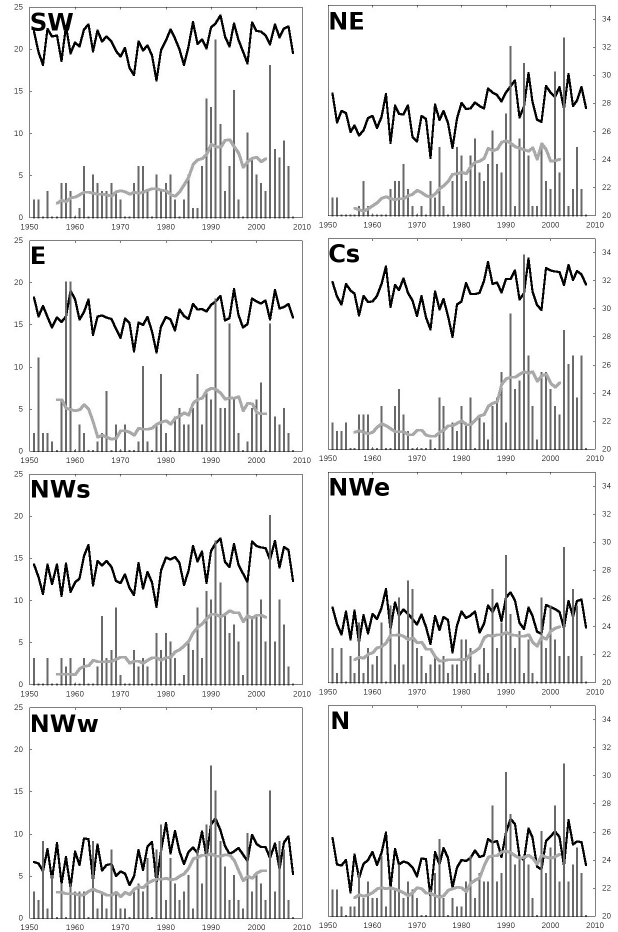
Figure 2. Temporal evolution of the eight regional series (see Fig. 1). The seasonal mean series of maximum temperature are rep- resented by the black bold curve (right y axis). The yearly number of regional EHDs and its running mean series (of 11 years) are de- picted by vertical bars and the grey curve, respectively (left y